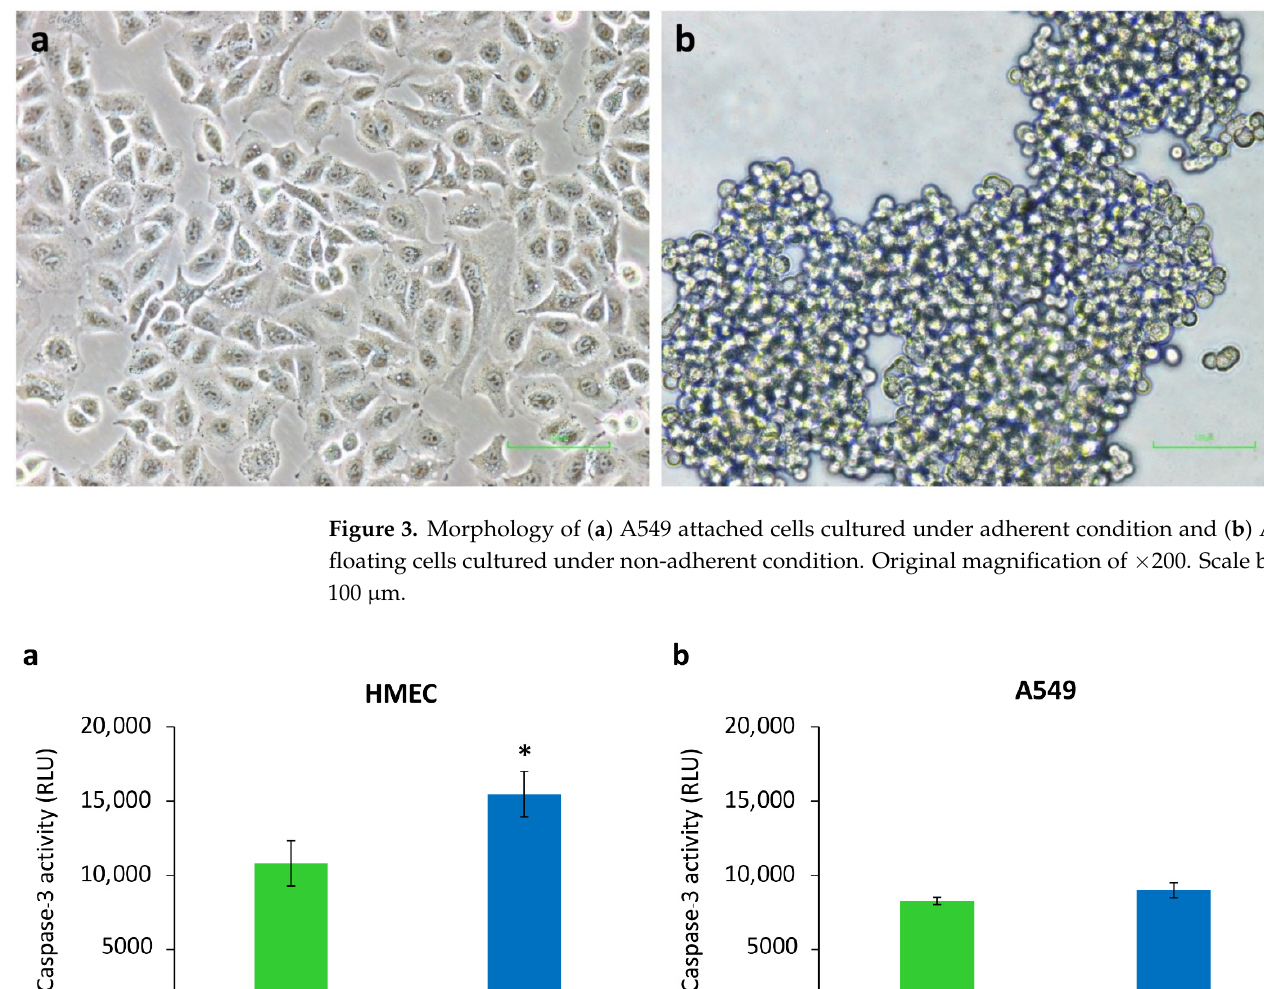
Figure 4. Caspase-3 activation in ( a ) human mammary epithelial cells/HMECs and ( b ) A549 cells after culturing under adherent condition (attached cells) and non-adherent condition (floating cells) for 24 h. Data are reported as mean ± SD from three independent experiments, * p < 0.05 compared to the attached cells.